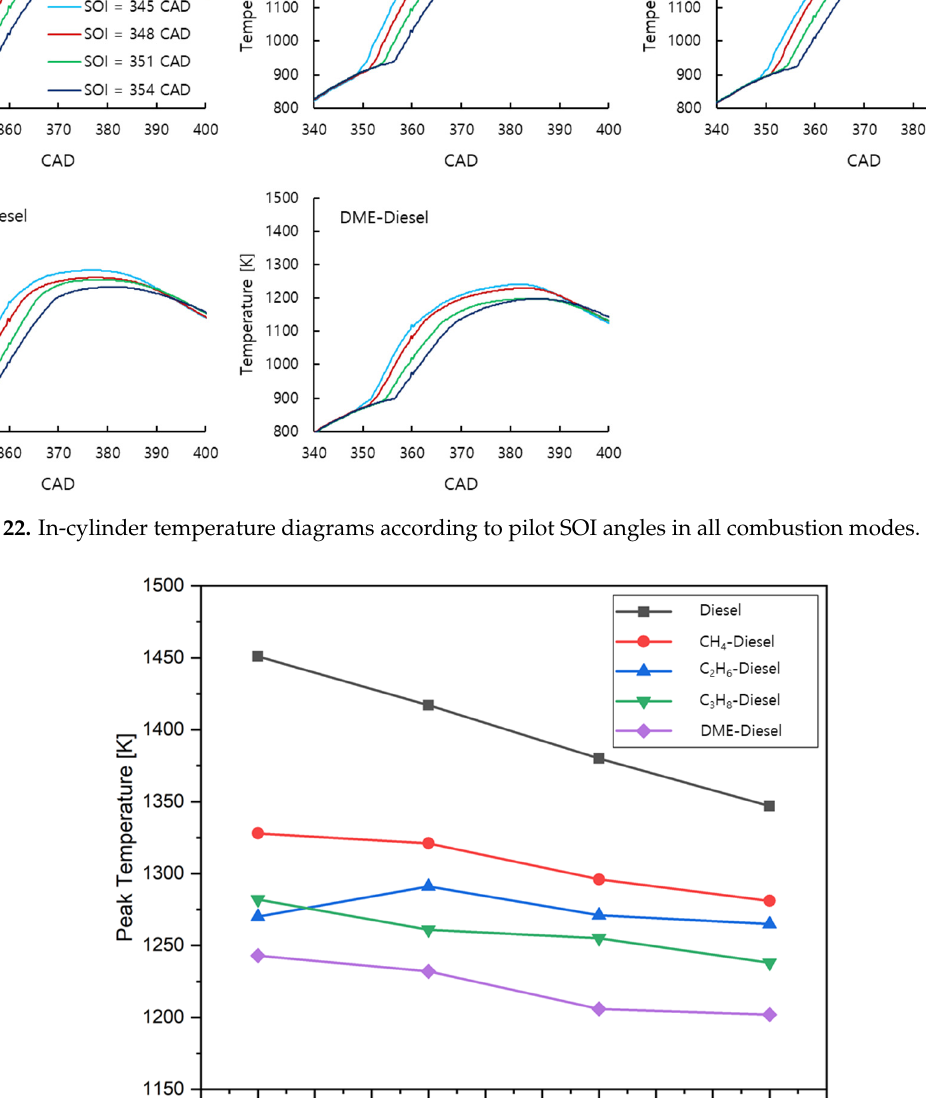
Figure 22. In-cylinder temperature diagrams according to pilot SOI angles in all combustion modes